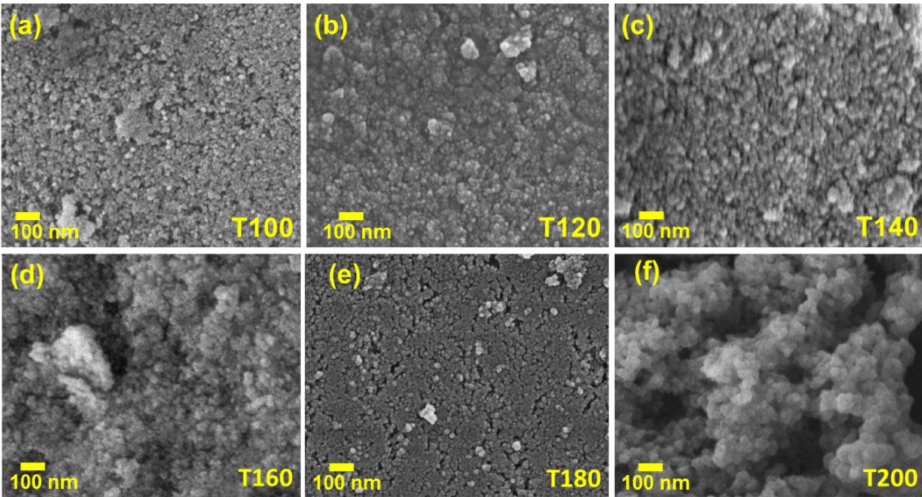
Figure 2. SEM images of TiO 2 NPs at different microwave hydrothermal temperatures, ( a ) 100 ◦ C, ( b ) 120 ◦ C, ( c ) 140 ◦ C, ( d ) 160 ◦ C, ( e ) 180 ◦ C, and ( f ) 200 ◦